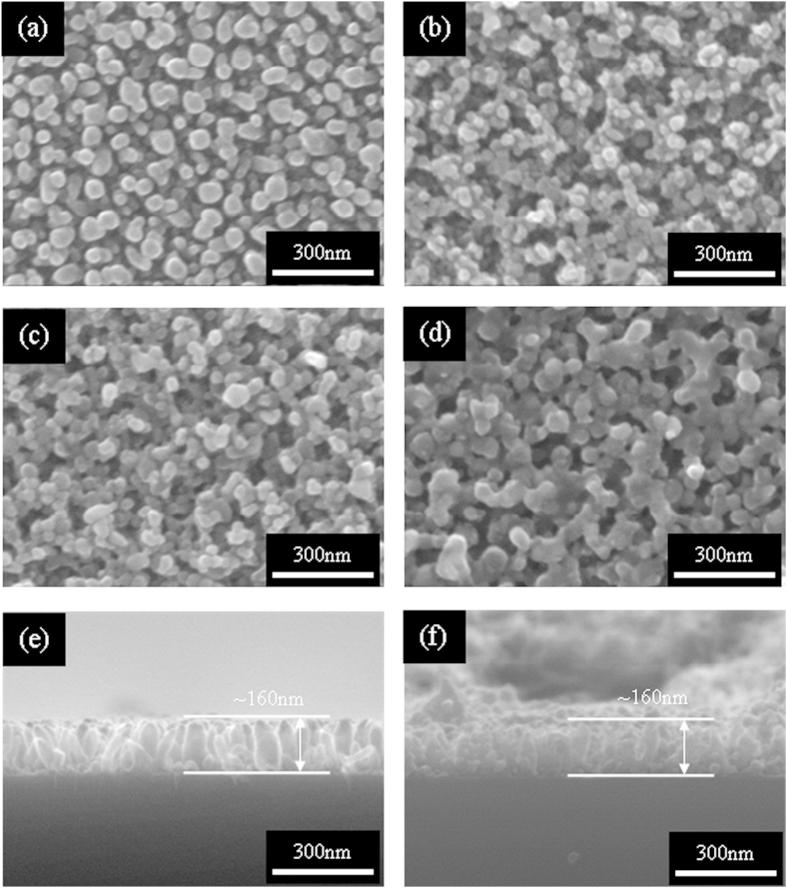
Top view SEM images of(a) bare TiO2, and different Ag2S-coupled TiO2 NRAs by SILAR method for (b) 20 cycles, (c) 30cycles, (d) 40 cycles; and side view of (e) bare TiO2 and (f) Ag2S-coupled TiO2 NRAs for 20 cycles.